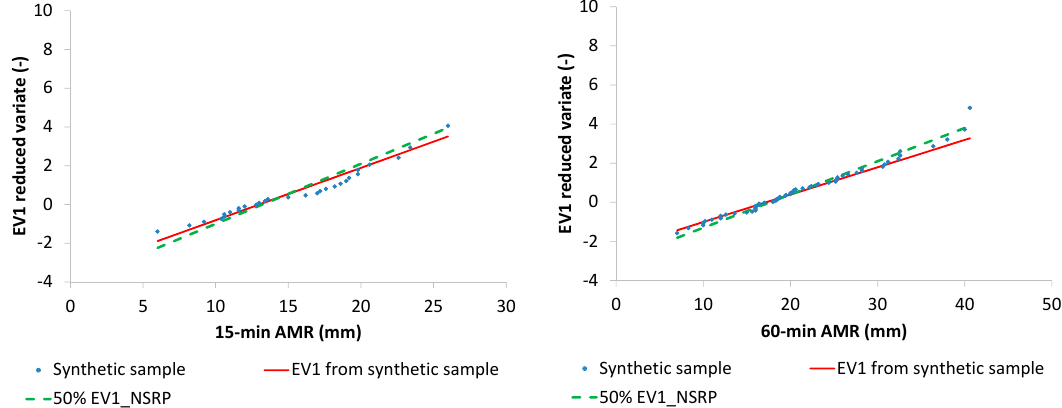
Figure 11. Cosenza rain gauge: EV1 probabilistic plots with AMR series, their EV1 theoretical curves and median EV1 curves from NSRP generation.